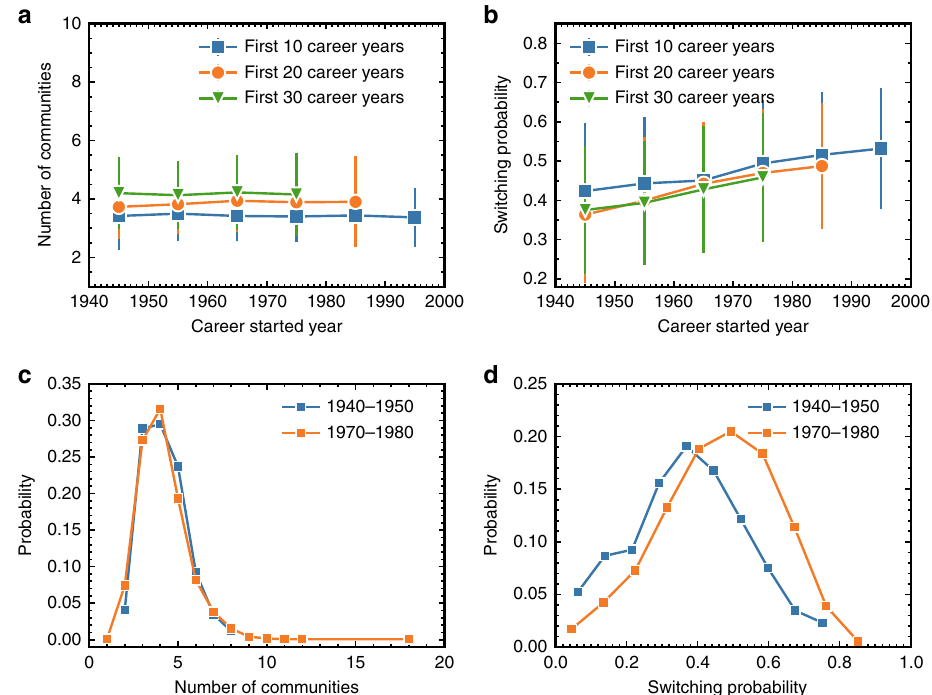
Fig. 4 Evolving trend of number of communities and switching probability as the development of science. a The mean number of communities of scientists who started their career in different years. b The average switching probability of scientists who started their career in different years. The error bars here represent standard deviations. As our data ends in 2010, it cannot capture the full career of scientists who started their careers in recent years. We thus fi lter out some scientists when we study the evolution of science here. We only consider scientists ’ fi rst y career years and remove (i) all the scientists that did not reach yet y years of career (for a fair temporal comparison), and (ii) those who published less than 30 papers in their fi rst y career years (for a meaningful community detection). The results of y = 10,20,30 are presented in this fi gure. As science evolves (during the years), the number of major communities that each scientist has stays almost unchanged, while the frequency that scientists switch between communities increases during the years. c Distributions of the number of communities (for y = 30) for scientists who started their career between 1940 and 1950, and for those who started their career between 1970 and 1980. The p -value of the Kolmogorov – Smirnov test is 0.961, suggesting a signi fi cant similarity between these two distributions. d Distributions of the switching probability (for y = 30) of scientists who started their career between 1940 and 1950, and of those who started their career between 1970 and 1980. The p -value of the Kolmogorov – Smirnov test is 2.34 × 10 − 8 , suggesting a signi fi cant difference between these two